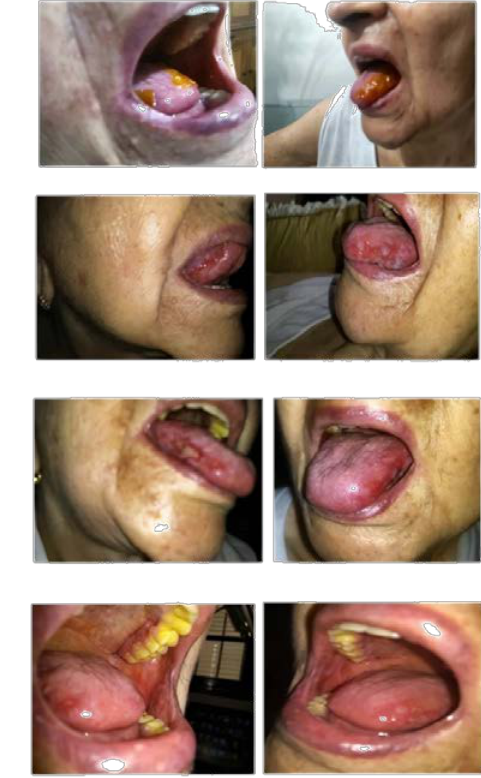
Figure 12. Pictures show lesions in both side of the tongue of the patient before treatment and suture points after a biopsy. The patient is 84 years old, and she had not received chemotherapy/radiotherapy treatment.